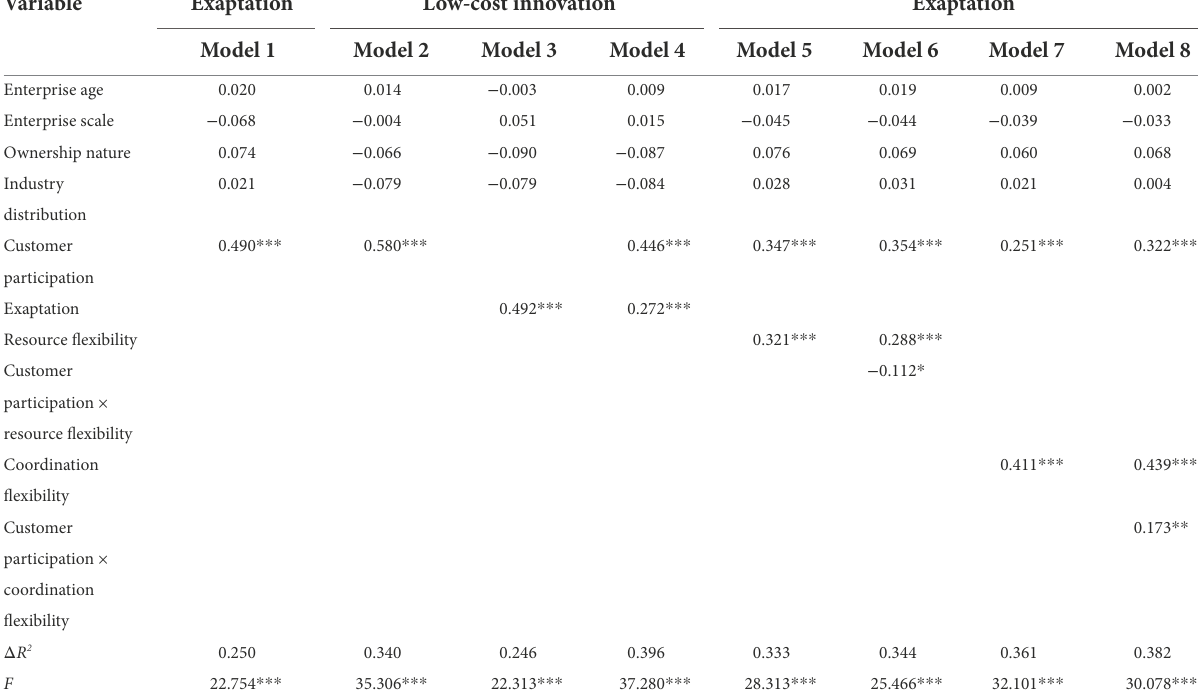
TABLE 3 Regression analysis results.